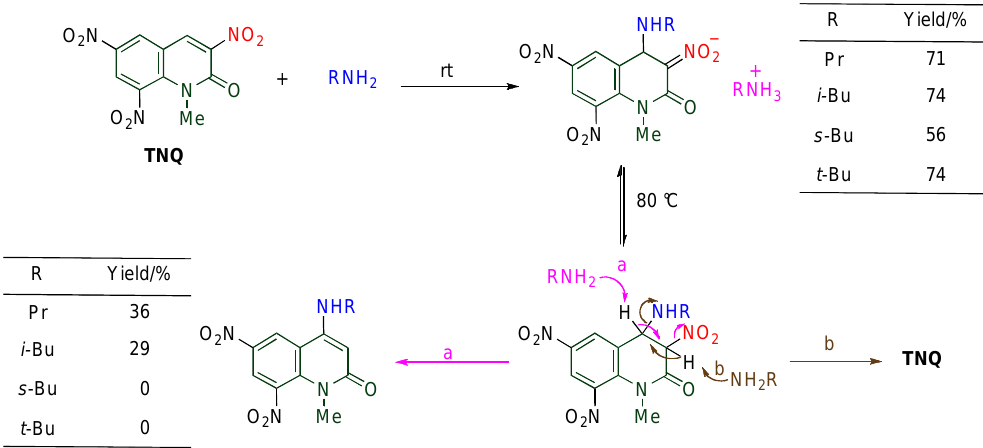
Table 6. Reaction of TNQ with primary